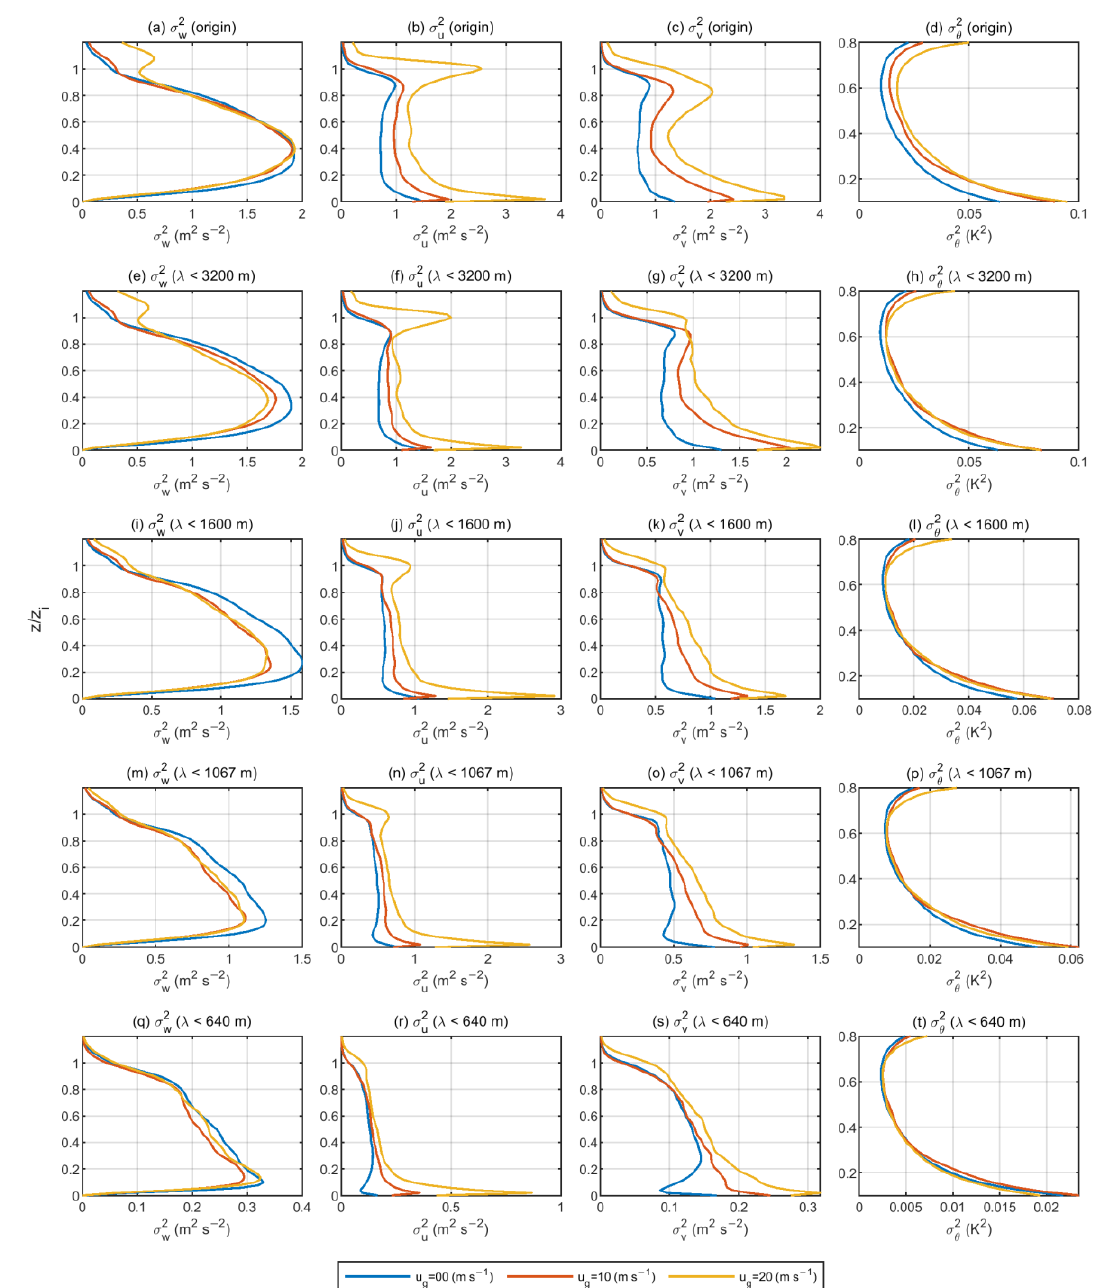
Figure 12. The vertical profiles of horizontal variances of w ( first column ), u ( second column ), v ( third column ), and θ ( last column ) data filtered by 2-d BHPF with cut-off wavenumber ( D 0 ) set as 3.125 × 10 − 4 m −1 (i.e., λ = 3200 m; second row ), 6.25 × 10 −4 m −1 (i.e., λ = 1600 m; third row ), 9.375 × 10 −4 m −1 (i.e., λ = 1067 m; fourth row ), and 1.25 × 10 −4 m −1 (i.e., λ = 800 m; last row ) from LES simulations at 3 h of physical time. The blue, red, and yellow lines represent U g = 0, 10, and 20 ms −1 , respectively. Note that the first row represents original vertical profiles of horizontal variances of w , u , v , and θ without filtering.